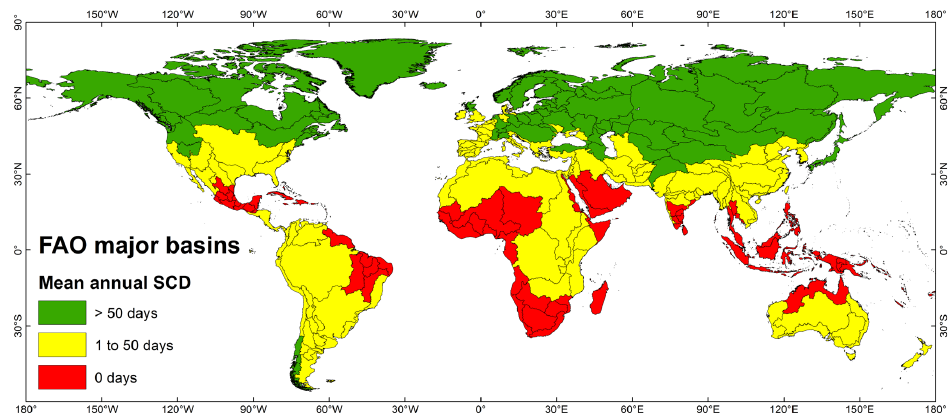
Figure 3. Overview of the catchment areas that are included in the analysis (green), that have only sparse snow cover (yellow) and that have no snow cover at all (red) (basins obtained from [46]). Figure 4 shows the selected catchment areas sorted according to their area extent and their average snow coverage. The largest catchment areas are the Siberian West Coast, the Northwest Territories and the Ob River. The greatest snow coverage is achieved for the islands of the Arctic Ocean (since Greenland is part of them).